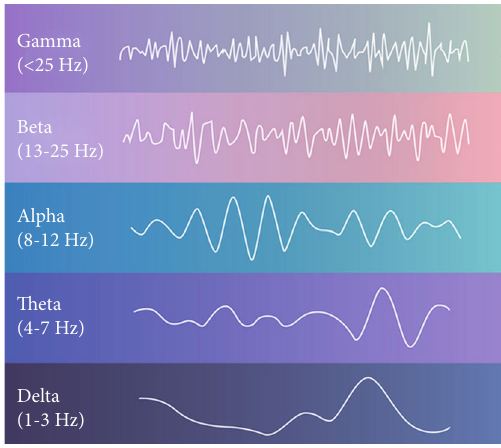
Figure 1: Architecture diagram of the proposed work.